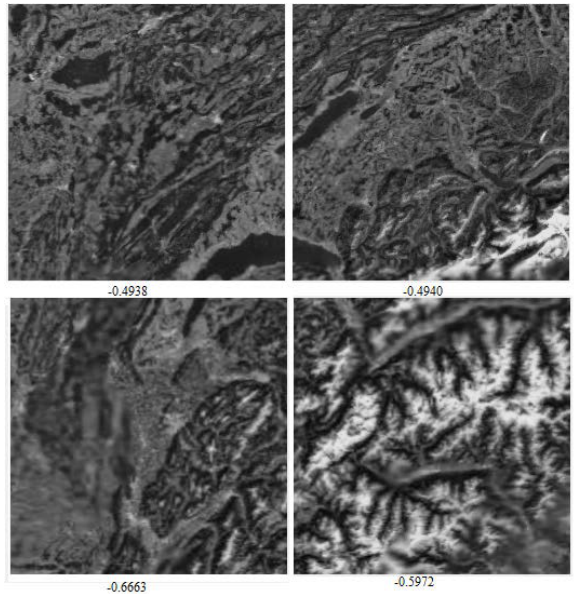
Fig. 3. Spatial correlation in blocks of 256 by 256